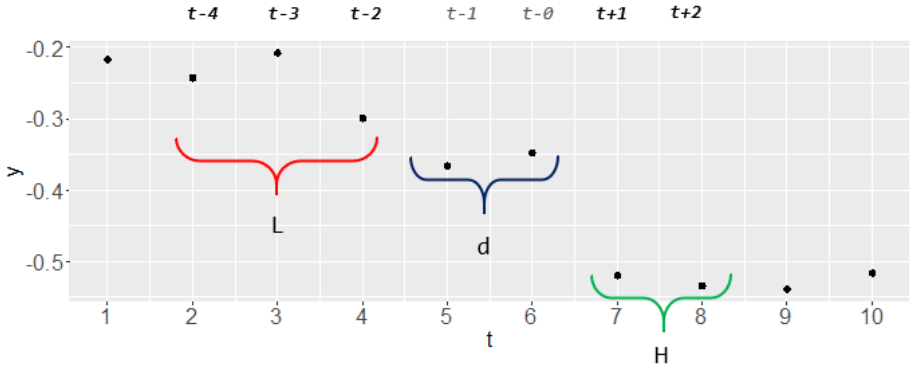
Figure 2. Visualization of key parameters in time-series supervised learning. Table 1. Most common smooth univariate